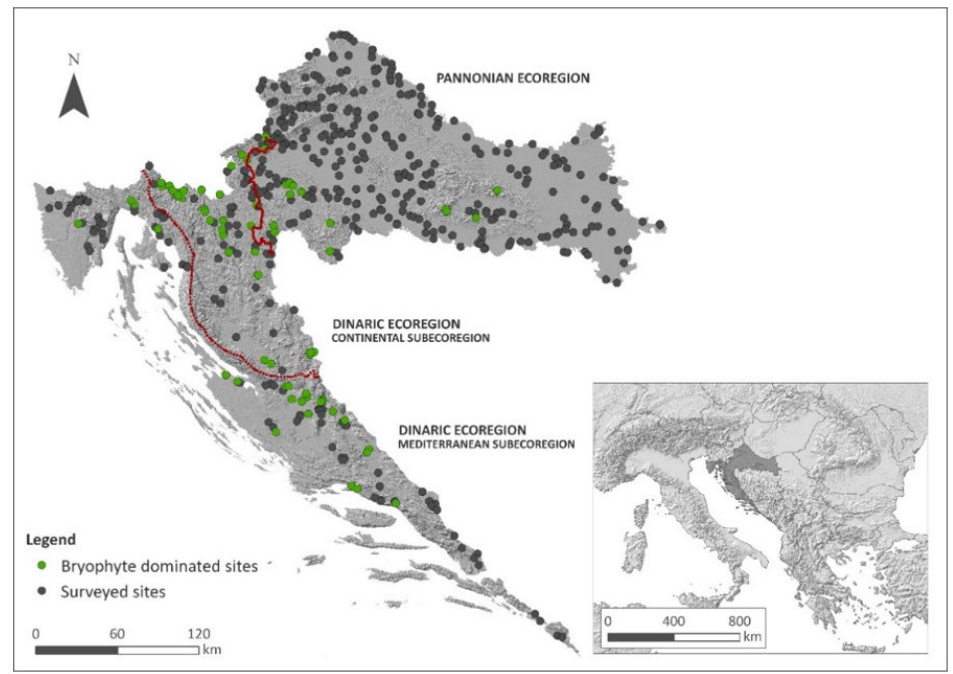
Figure 11. Study area with 527 sampling sites distributed across Croatia (Southeast Europe).